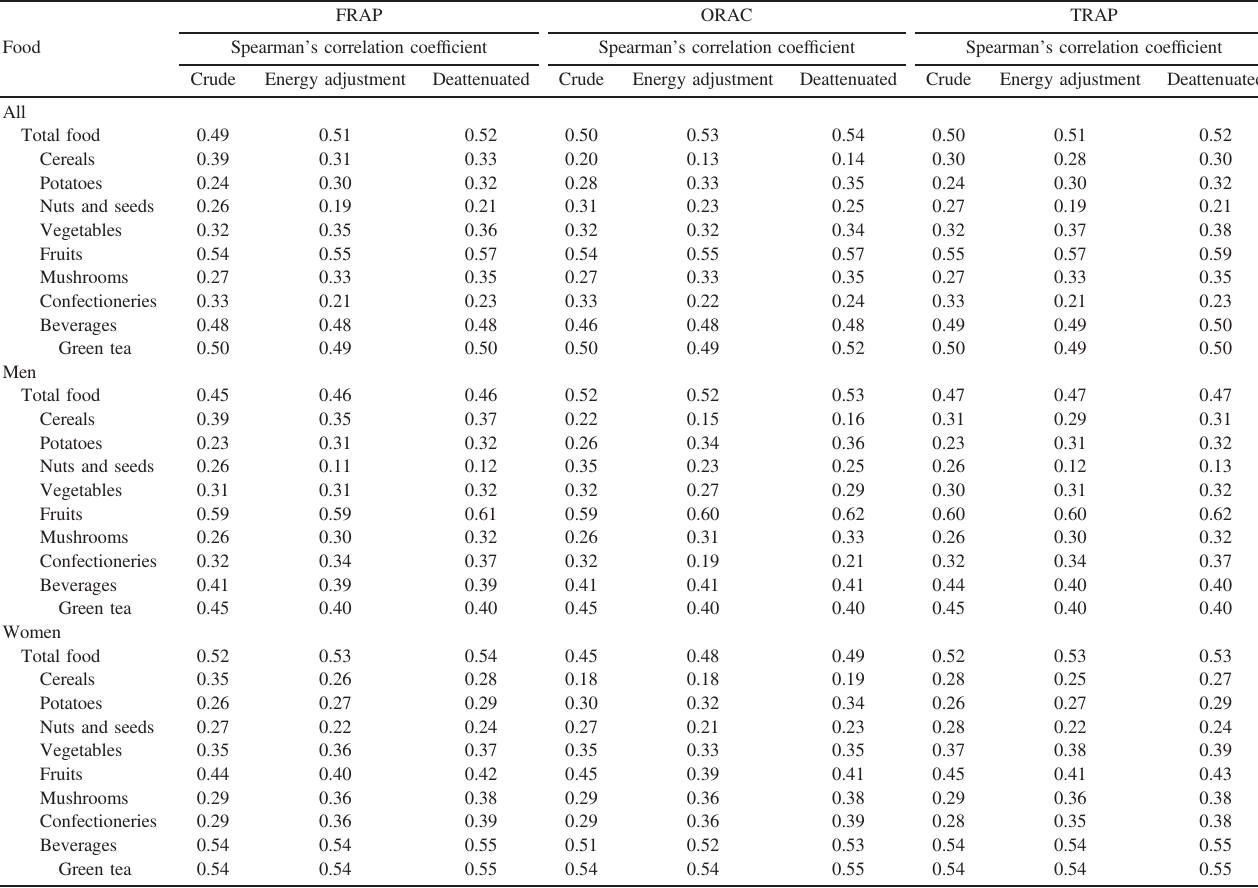
Table 3. Ranking validity of FFQ-based NEAC of foods and beverages by comparison to 28-day DR FRAP ORAC Food